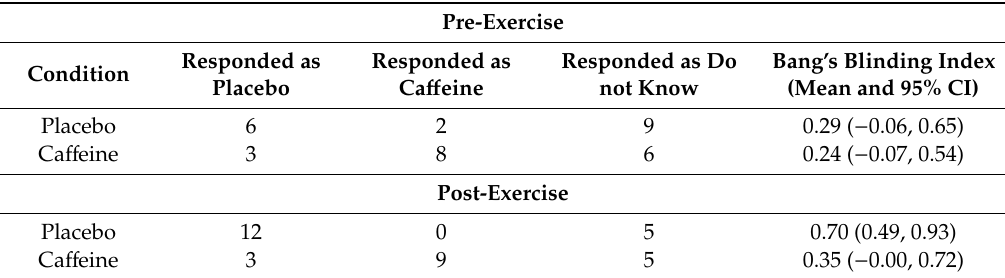
Table 4. Results of the assessment of blinding pre- and